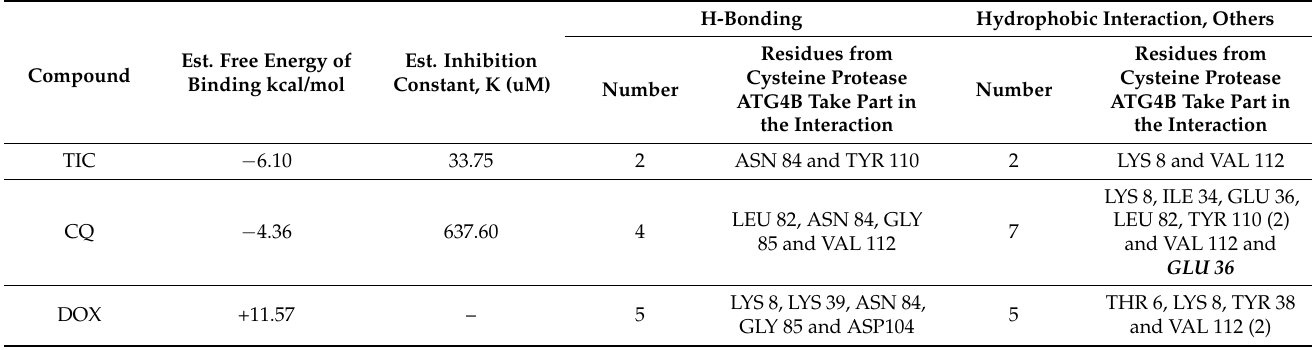
Table 1. Results of the docking of FDA-approved drugs and the interactions constructed on the crystal structure of ATG4B (PDB ID: 2Z0D).